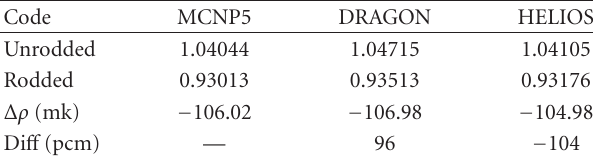
Table 4: Results: idealized rodded